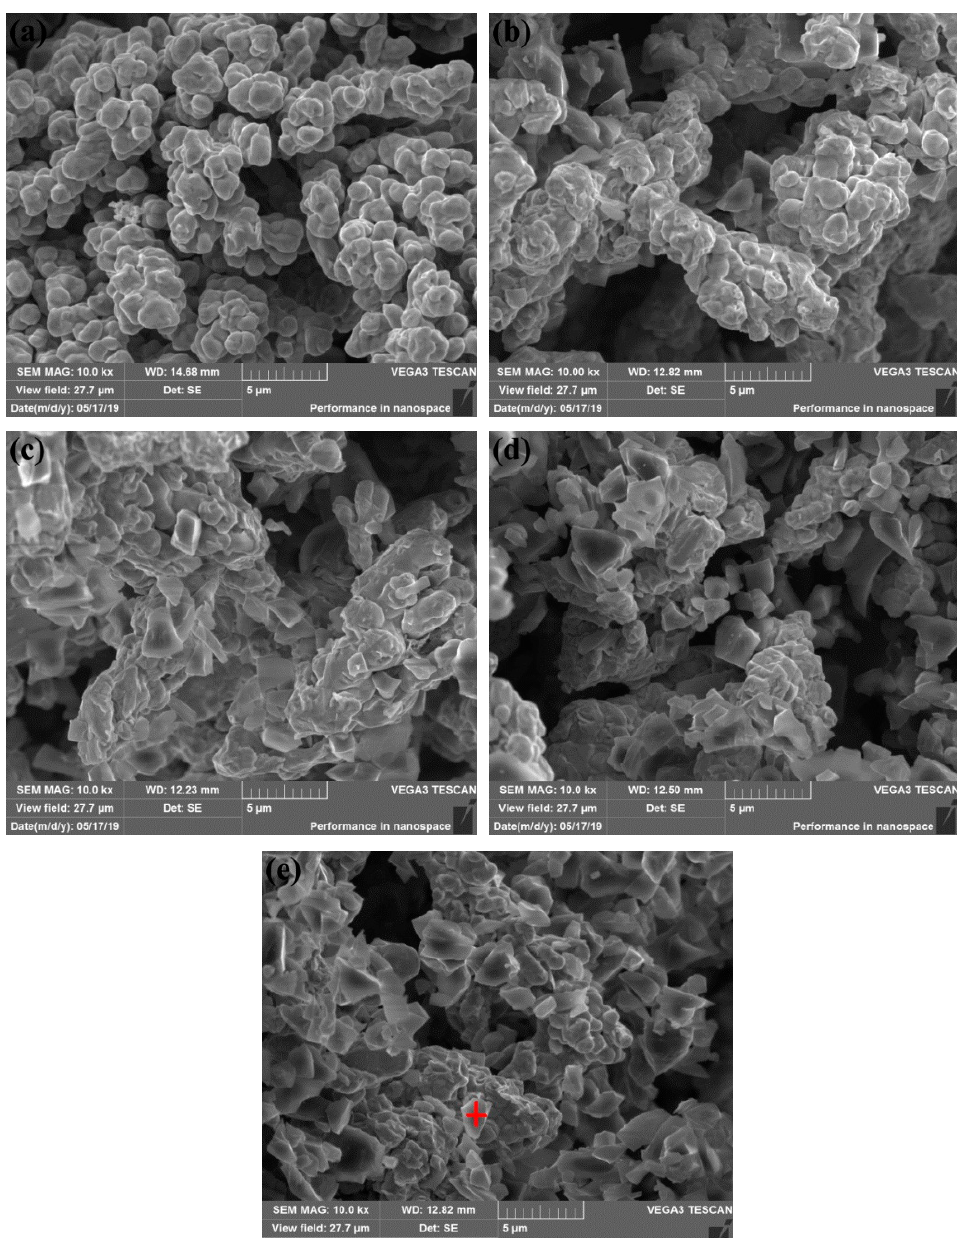
Figure 3. The B 4 C/Cu composite powder morphologies with different amounts of B 4 C: ( a ) Cu; ( b ) Cu-5 wt.% B 4 C; ( c ) Cu-10 wt.% B 4 C; ( d ) Cu-15 wt.% B 4 C; ( e ) Cu-20 wt.% B 4 C.